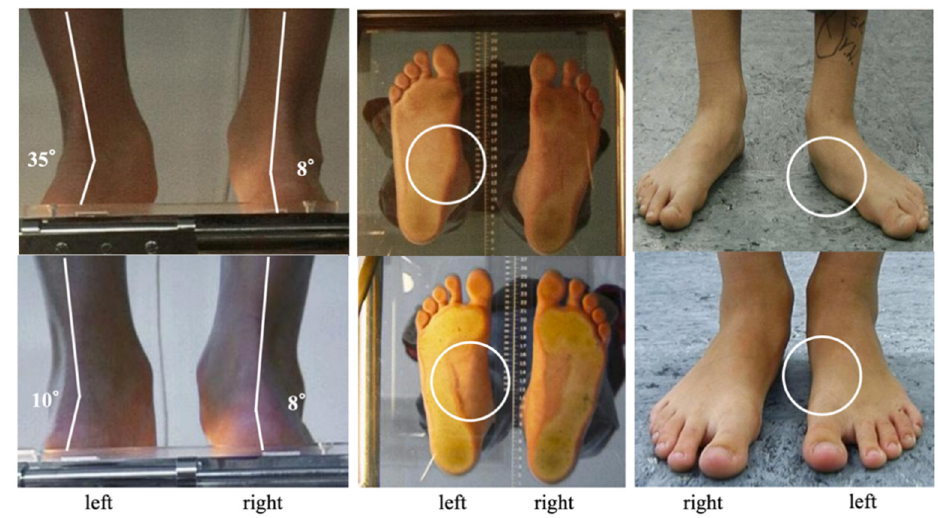
Figure 2. Pre- and postoperative clinical and podoscopic assessment. A 12-year-old boy received a subtalar extra-articular screw arthroereises (SESA) for painful unilateral flexible flatfoot (FFF) on the left side. While preoperatively typical FFF pattern was noticeable ( top ) the postoperative clinical and podoscopic examination depicted a good correction of the hindfoot valgus and the medial arch ( bottom ) (same patient as shown in Figures 3–5).